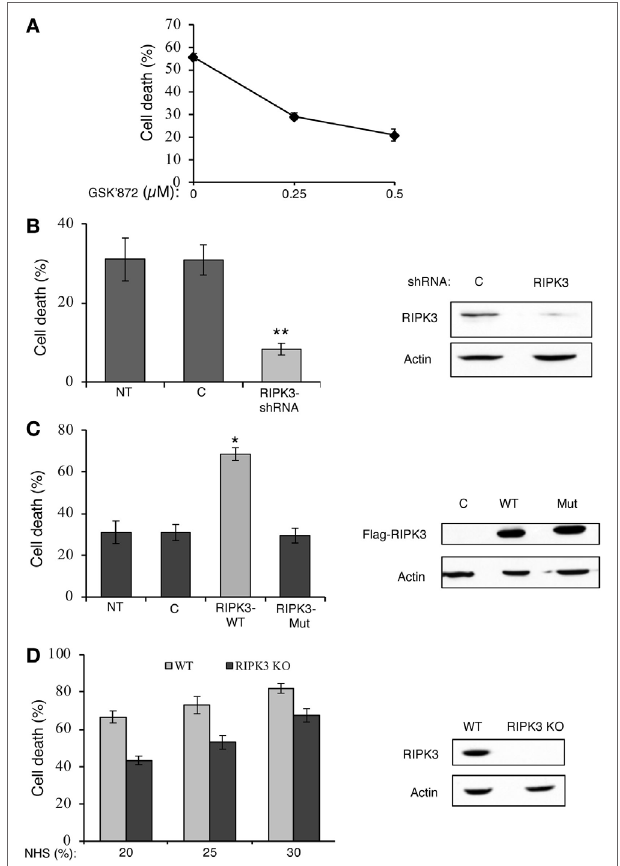
FigUre 2 | Receptor-interacting protein kinase 3 (RIPK3) contributes to complement-induced cell death (CD). (a) K562 cells were pretreated with GSK’872 or with DMSO as control for 1 h at 37°C and then treated with antibody and complement. The percentage of CD was analyzed by propidium iodide inclusion. Statistical analysis showed that GSK’872 significantly inhibited CD (one-way-ANOVA, P < 0.01). (B) K562 cells were transfected with a RIPK3-shRNA plasmid or an empty vector (c) as control. After 48 h, the cells were treated with antibody and complement and CD was quantified. Transfection with RIPK3-shRNA significantly reduced CD relative to empty vector ( t -test, P < 0.01). RIPK3 knockdown was confirmed by Western blotting analysis of cell lysates (shown on the right) . (c) K562 cells were transfected with plasmid DNA expressing Flag-tagged wild-type (WT) RIPK3 (RIPK3-wt), RIPK3 kinase-dead mutant (RIPK3-mut), or with its empty vector (c) . After 30 h, the cells were treated with antibody and complement and CD was determined. Transfection with RIPK3-wt significantly enhanced CD relative to empty vector and RIPK3-mut ( t -test, P < 0.05). To confirm the expression of the flagged proteins, cell lysates were subjected to Western blotting analysis with anti-Flag and anti-actin antibodies (shown on the right). (D) WT and RIPK3 KO mouse embryonic fibroblasts (MEFs) were treated with normal human serum (NHS) (20, 25, or 30%) for 1 h at 37°C. The percentage of CD was determined by trypan blue exclusion. Statistical analysis showed that RIPK3 KO MEF is significantly less sensitive to complement-dependent cytotoxicity than is WT MEF (two-way-ANOVA, P < 0.001). Yet, the two cell types reacted similarly to increasing concentrations of complement (two-way-ANOVA, P = 0.148). Lysates of WT and RIPK3 KO MEFs were analyzed by Western blotting with anti-RIPK3 and anti-actin antibodies (shown on the right). Results are expressed as mean percentage of CD ± SD. Data shown represent at least three independent experiments. NT, not transfected